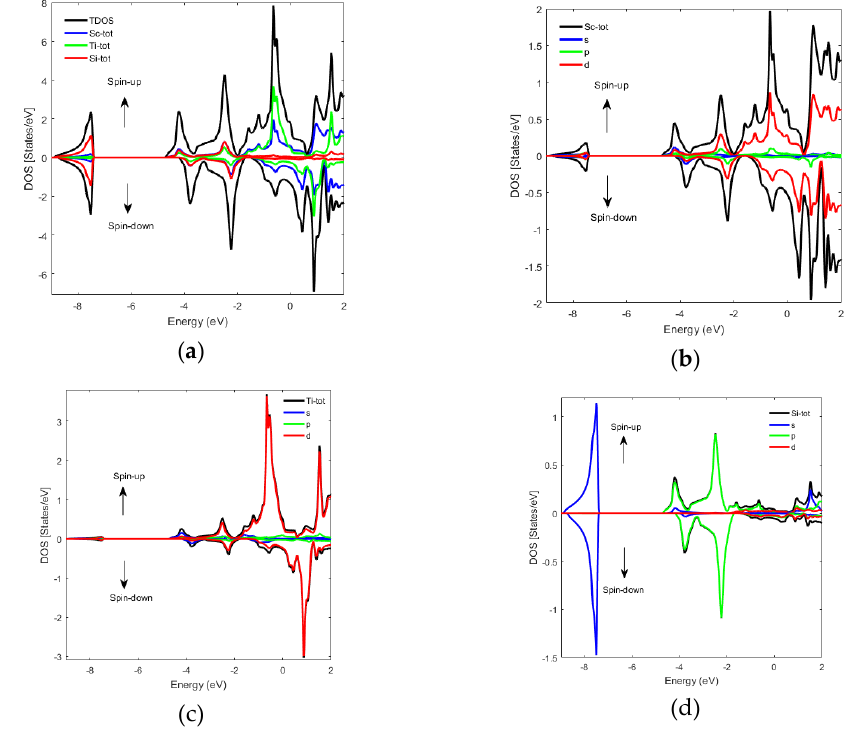
Figure 6. ( a ) TDOS for regular Sc 2 TiSi, and PDOS for the ( b ) Sc atom, ( c ) Ti atom, and the ( d ) Si atom.